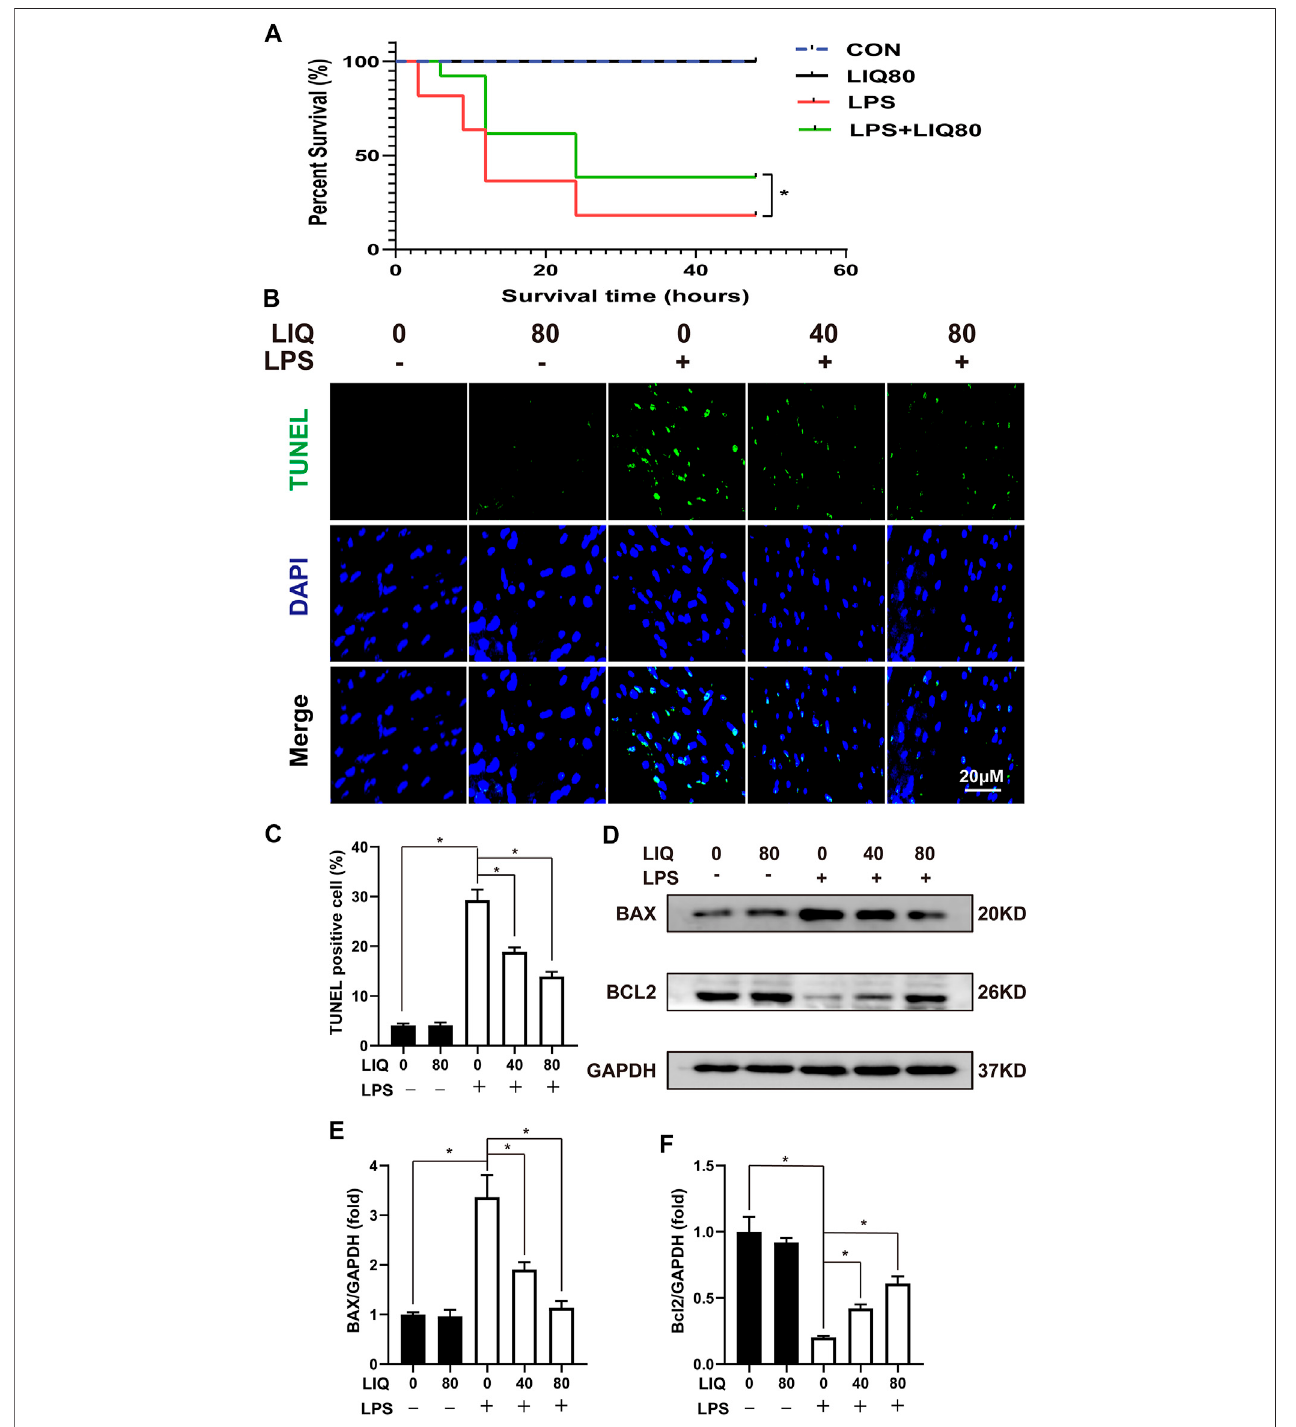
FIGURE3 | LIQ treatment suppressed LPS-induced oxidative stress and apoptosis in vivo . (A) Mice were treated withLPS (30 mg/kg, intraperitoneal injection) for observing 48 h to draw survival curves ( n (cid:2) 20), (B) TUNEL staining was performed to examine cellular apoptosis in mouse hearts ( n (cid:2) 6), (C) Calculating the TUNEL positive nucleus ( n (cid:2) 6), (D) Representative western blots of BAX, Bcl-2 and GAPDH, (E,F) relative quantitative results of BAX/GAPDH and Bcl-2/GAPDH ( n (cid:2) 6). * p < 0.05 compared with the indicated group, the data were expressed as the Mean ± SEM and were compared by one-way ANOVA with Tukey post hoc analysis, A log-rank test was used to compare survival